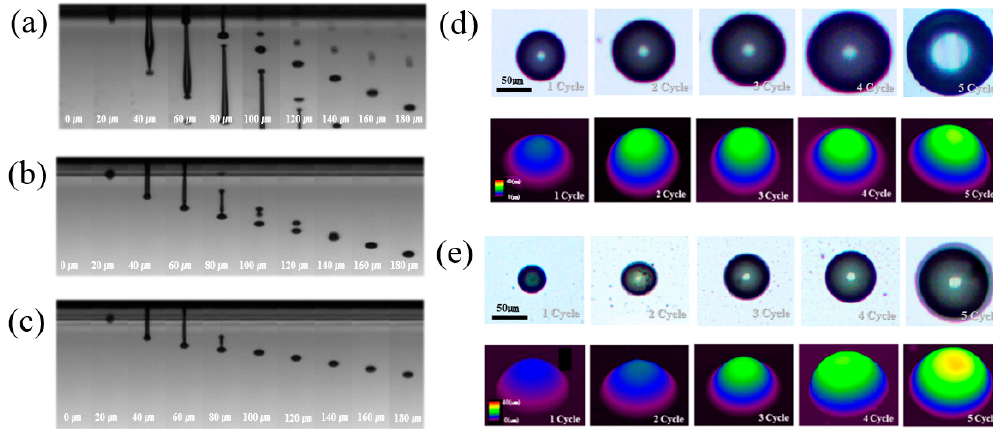
Figure 3. Operation conditions of ink-jet printing using ( a ) nano SiO 2 ink before rheological optimization; ( b ) nano SiO 2 ink; and ( c ) modified nano SiO 2 ink after rheological optimization; microscope images of ink-jet 3D printed dot using ( d ) nano SiO 2 ink and ( e ) modified nano SiO 2 ink.